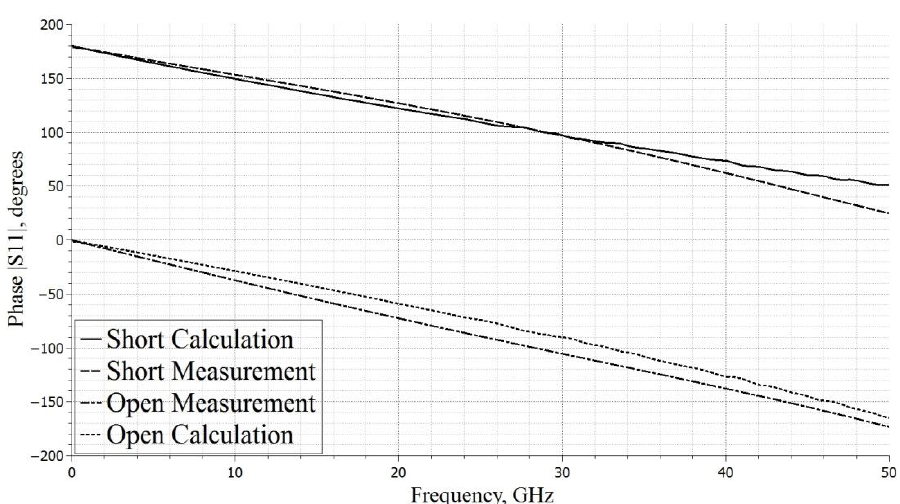
Fig. 9. Measured vs simulated phase balance for OPEN and SHORT states.